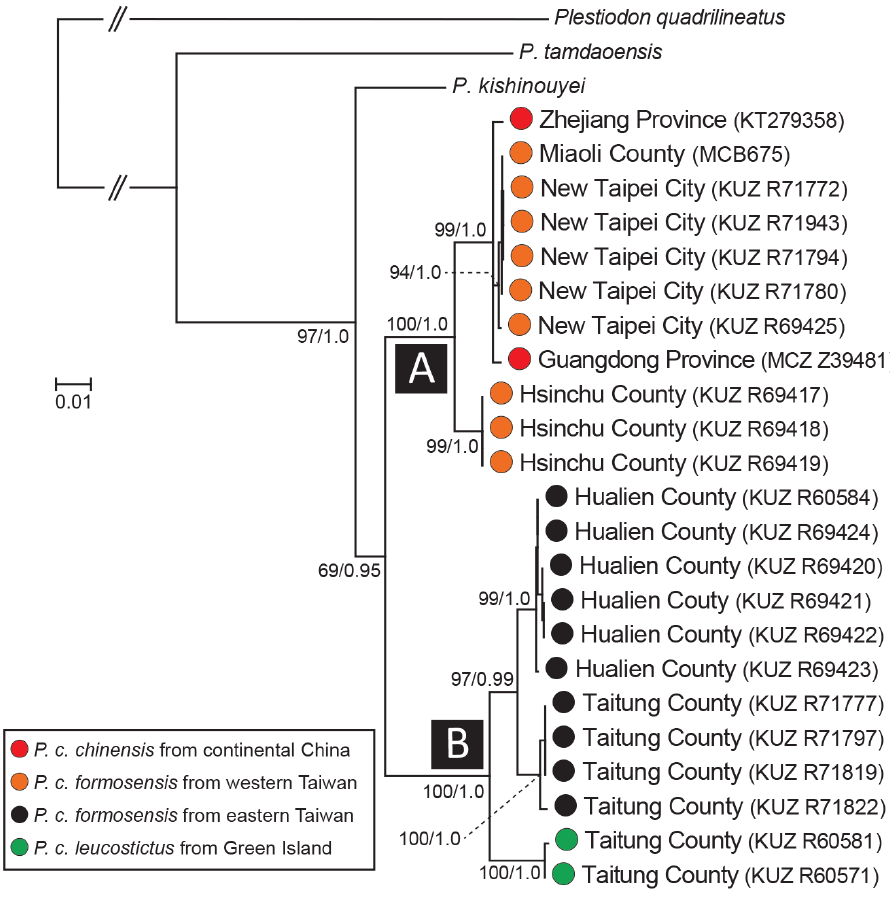
Figure 3. Maximum likelihood tree estimated using mitochondrial DNA sequences (2,351 bp). Num- bers near interior branches show the bootstrap probabilities/Bayesian posterior probabilities. Sample names correspond to those given in Table